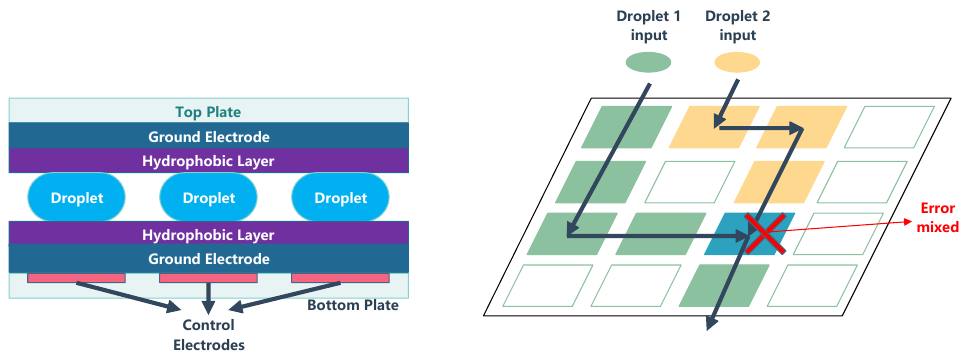
Figure 4. Schematic diagram of the digital microfluidic biochips (DMFB) structure and path error.